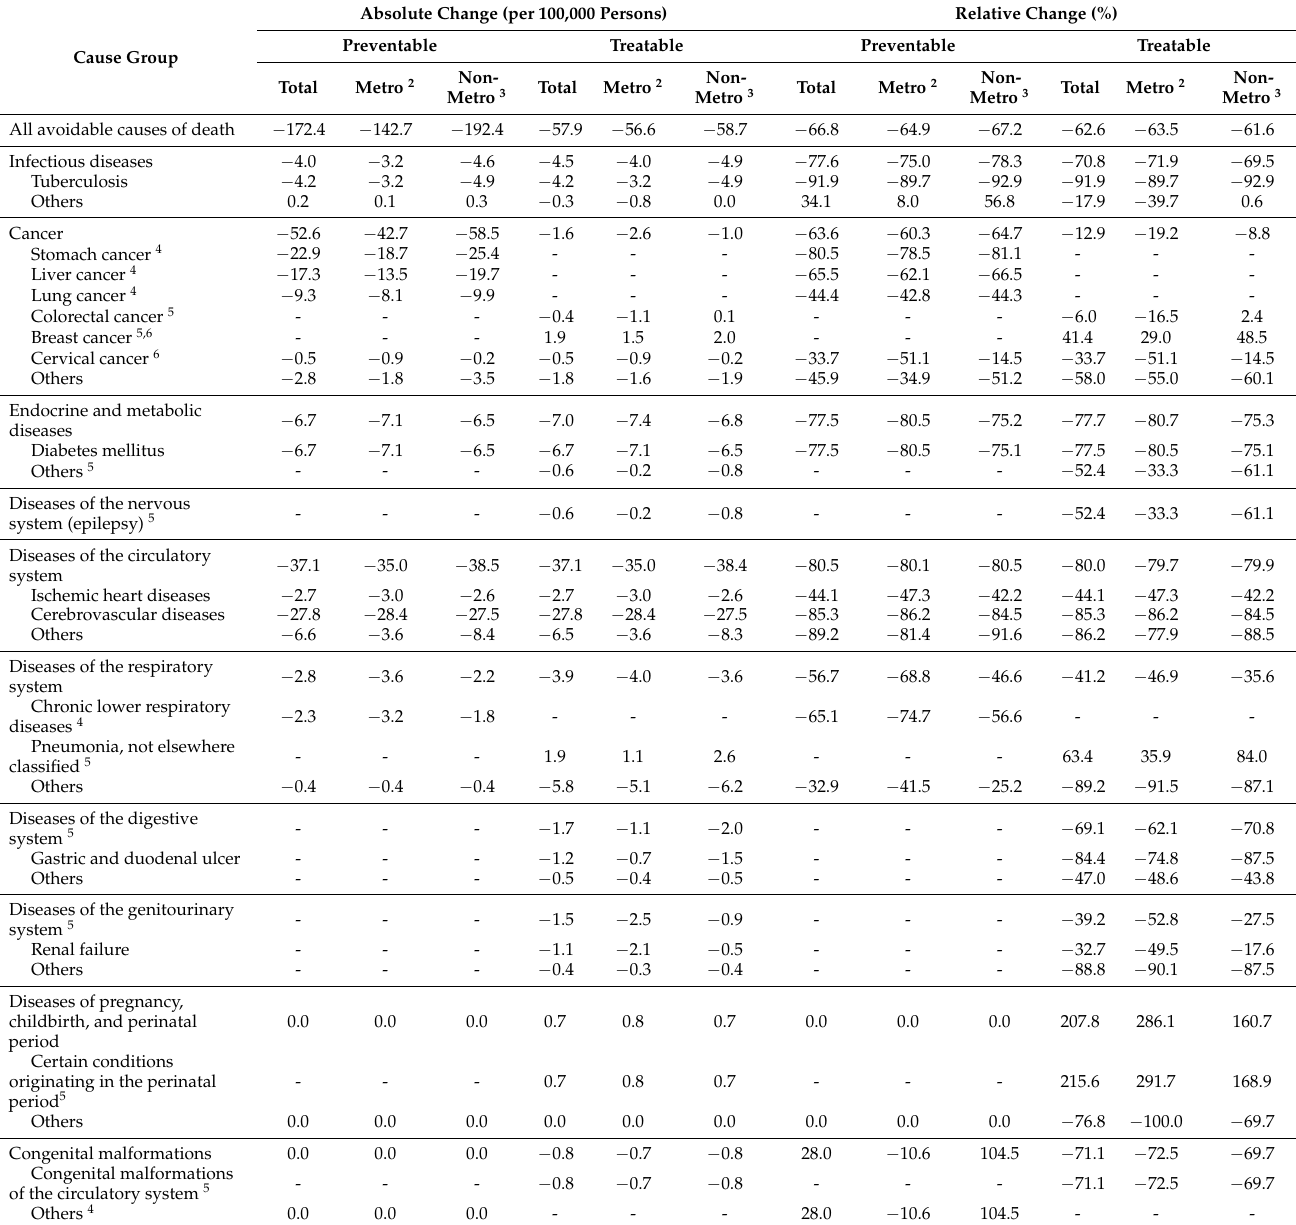
Table 2. Absolute and relative changes of cause-specific avoidable mortality rate according to the type of areas from 1995 to 2019 1